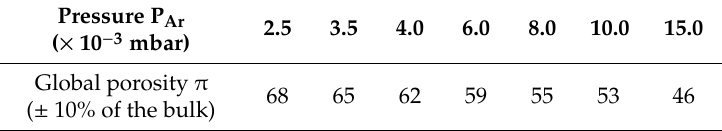
Table 2. Calculated porosity as a function of the argon sputtering pressure.